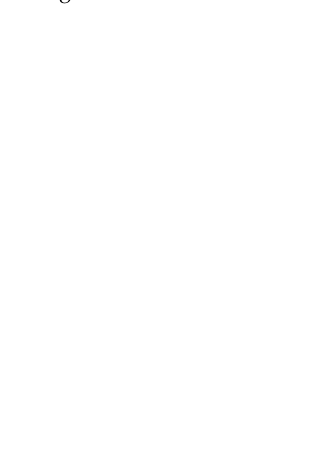
Figure 10. Generated original centerline.